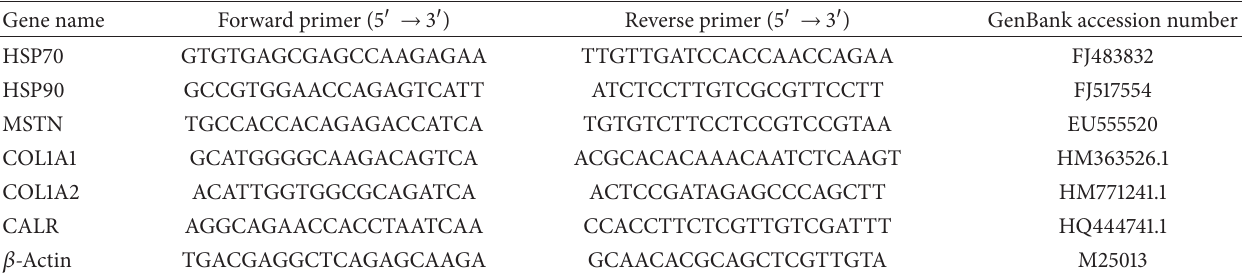
Table 1: Primers used in quantitative real-time